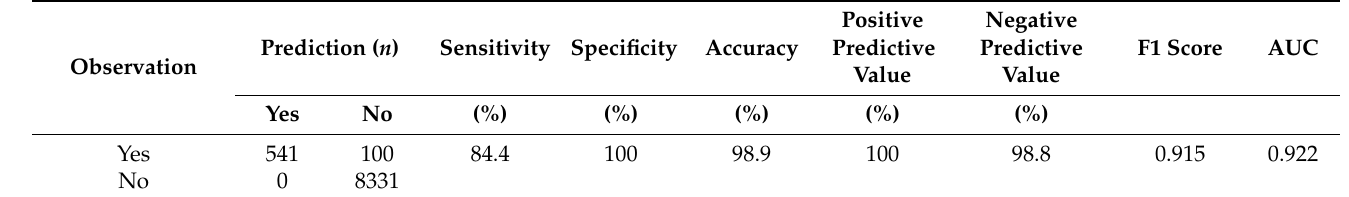
Table 2. Confusion matrix and prediction scores of random forest model with all